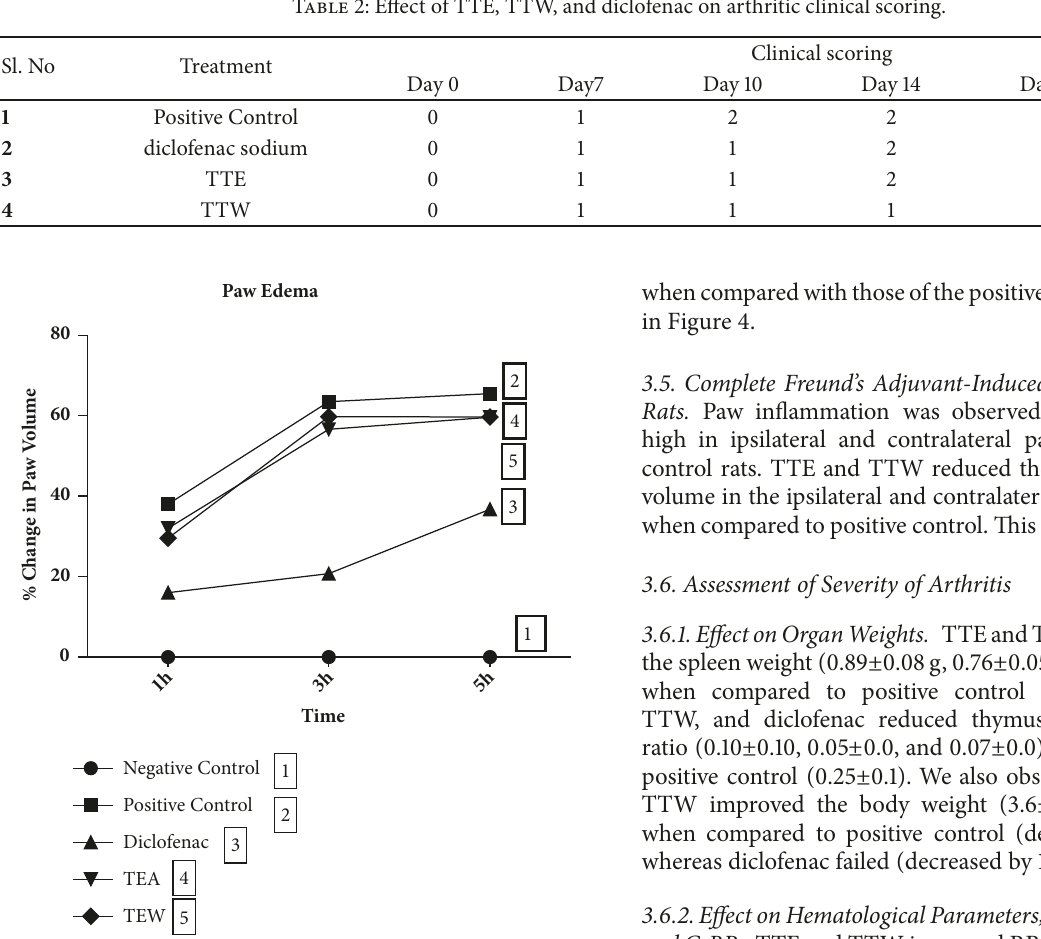
Figure 3: Carrageenan-induced hind paw edema in Wistar rats, diclofenac sodium used as a standard drug and compared with the effect of ethanolic and water extracts of T. tomentosa